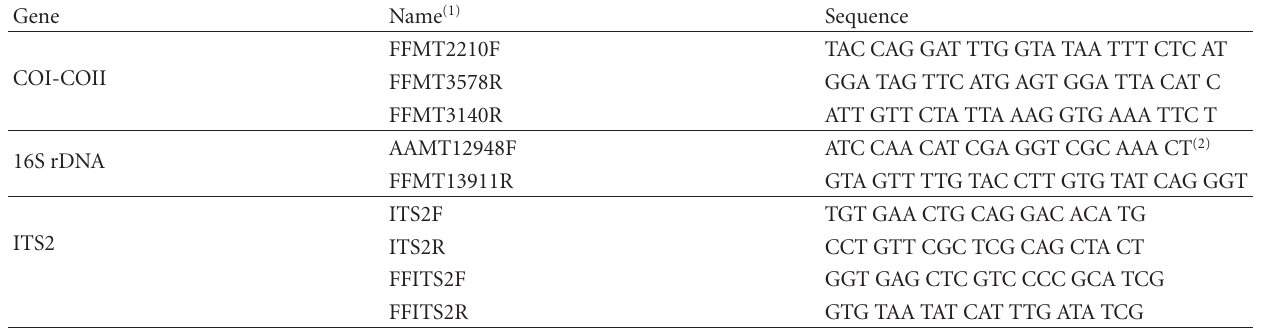
Table 2: PCR primers used in this study shown in 5 (cid:2) –3 (cid:2)